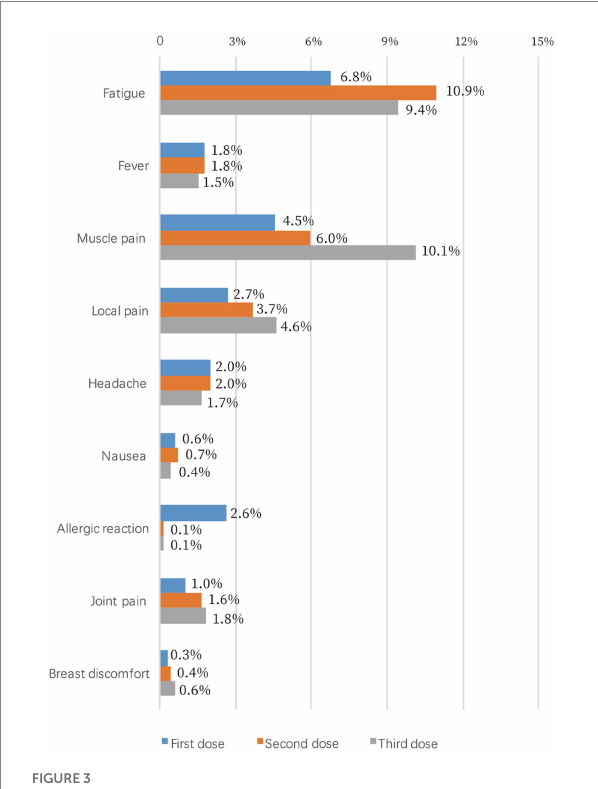
FIGURE 3 Side effects of COVID-19 vaccines.